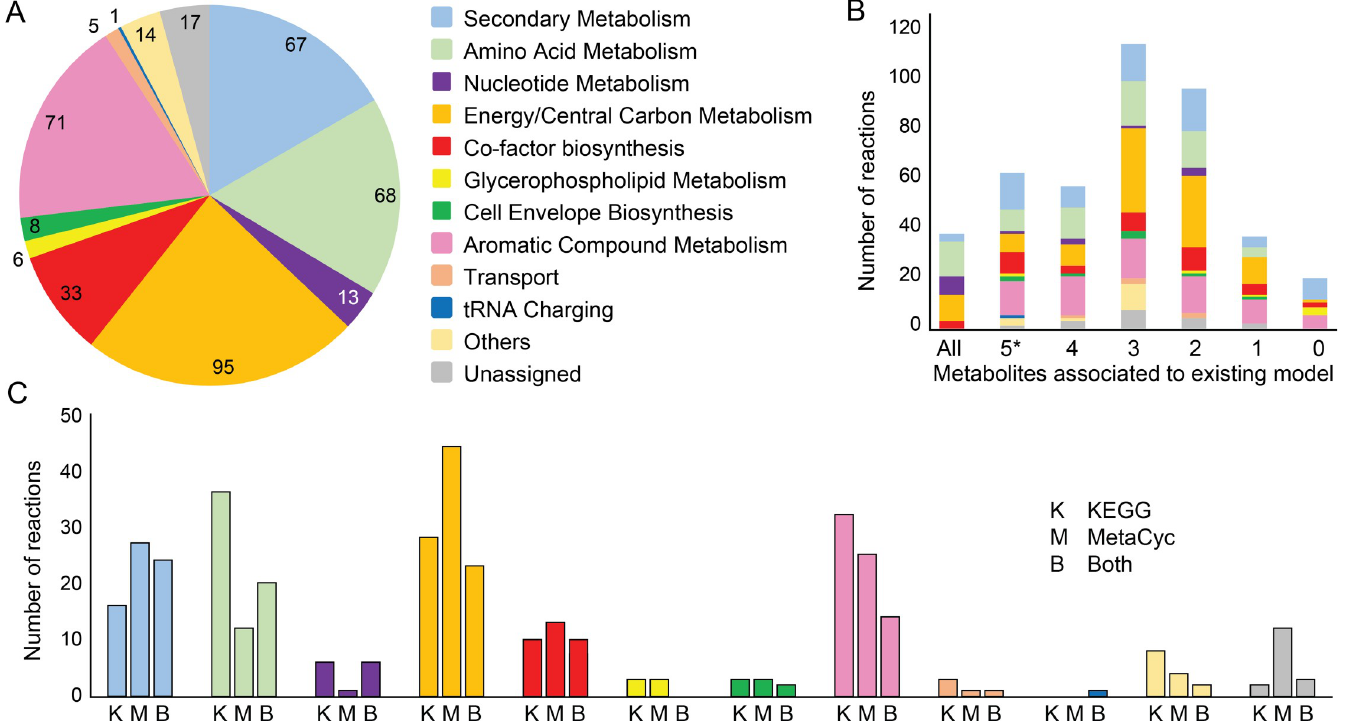
Fig 4. The compositional subsystem distribution of the new reactions selected from the combined draft model. (A) A total of 398 metabolic reactions were introduced in Sco4, thereby expanding the coverage in both primary and secondary metabolism. (B) These 398 curated reactions were identified through either KEGG- and/or MetaCyc-based de novo reconstructions. (C) Metabolites from these new reactions are closely associated with the previous S . coelicolor GEM. Over 95% of the reactions have one or more metabolites included in iMK1208, and 36 reactions have all reactants and products included in the previous model, resulting in increased connectivity of the network; while only 19 reactions have all newly introduced metabolites, representing completely new stoichiometric network reconstructed by RAVEN 2.0.